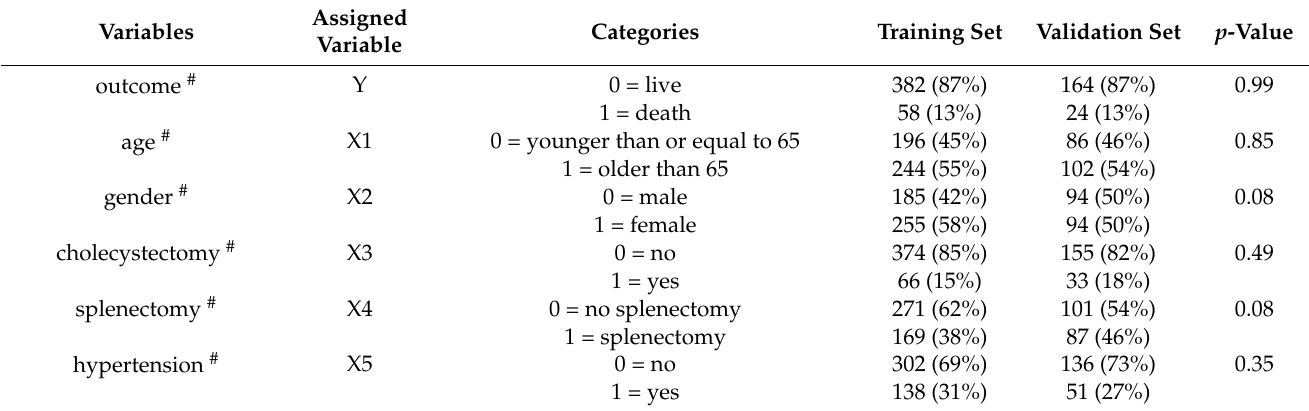
Table 1. Characteristics of patients with advanced schistosomiasis in this